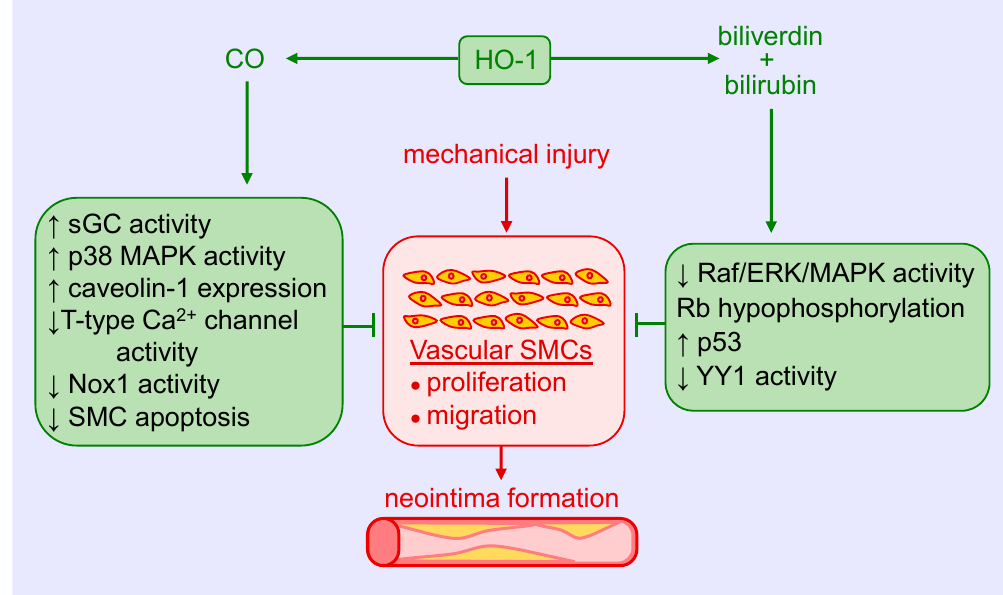
Figure 2. Heme oxygenase-1 (HO-1) inhibits vascular smooth muscle cell (SMC) proliferation and migration, and neointima formation following mechanical injury of arteries via the generation of carbon monoxide (CO), biliverdin, and bilirubin. CO blocks SMC proliferation and migration by stimulating soluble guanylate cyclase (sGC) activity, p38 mitogen-activated protein kinase (MAPK) activity, and caveolin-1 expression, and by reducing T-type calcium (Ca 2 + ) channel activity, nicotinamide adenine dinucleotide phosphate oxidase 1 (Nox1) activity, and SMC apoptosis. Biliverdin and bilirubin attenuate SMC proliferation and migration by restraining rapidly accelerated fibrosarcoma (Raf) / extracellular-signal-regulated kinase (ERK) / MAPK activity, retinoblastoma protein (Rb) phosphorylation, and the expression of the transcription factor Yin Yang 1 (YY1), and by increasing p53 expression.